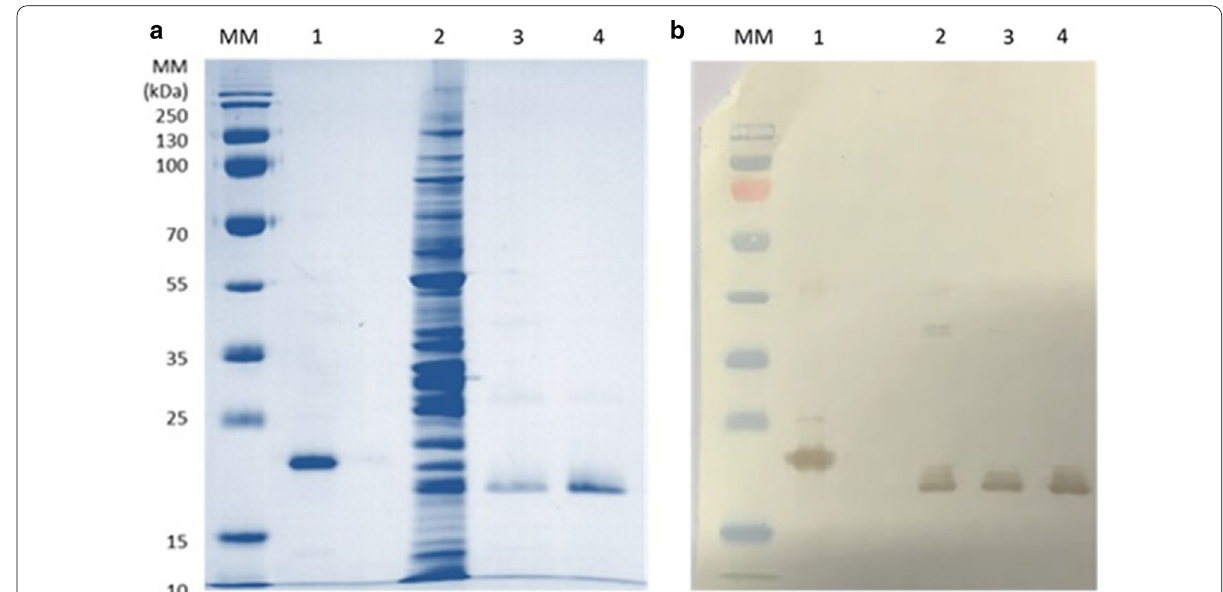
Fig. 5 Comparative analysis of the chromatographic steps of Δ 1-11 -G129R-hPRL by SDS-PAGE under non-reducing conditions ( a ) and Western Blotting ( b ). (MM) molecular mass standards, (1) hPRL, (2) periplasmic fluid, (3) pool from IMAC and (4) pool from